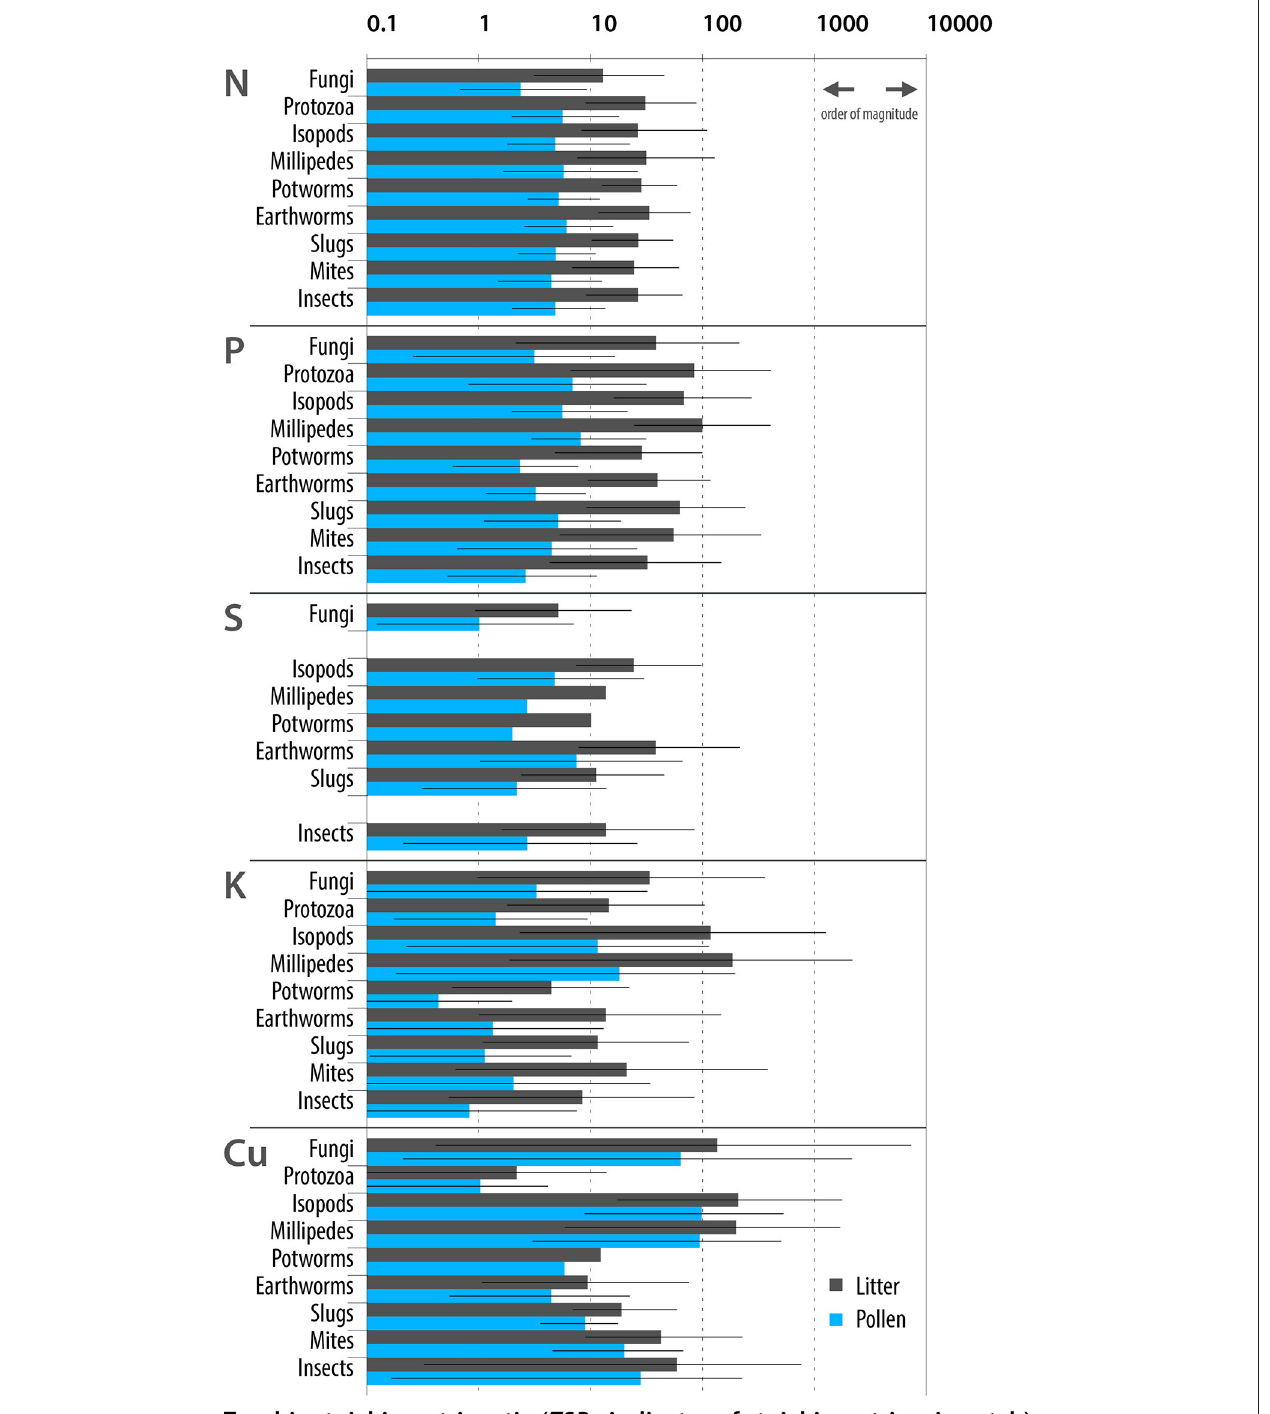
FIGURE 1 | Stoichiometric mismatches ( TSRs ) calculated for detritivorous soil and litter dwellers that may utilize pollen as a supplementary food. TSR values were calculated for the two sources of food: pine litter and pine pollen. Bars denote means; whiskers denote minima and maxima. Various pine species inhabiting different forests in diverse locations were considered. The scale of the Y-axis is logarithmic. After lowering any mismatches by approximately one order of magnitude, feeding on pollen mitigated N, P, S, and K nutritional mismatches in a variety of organisms.